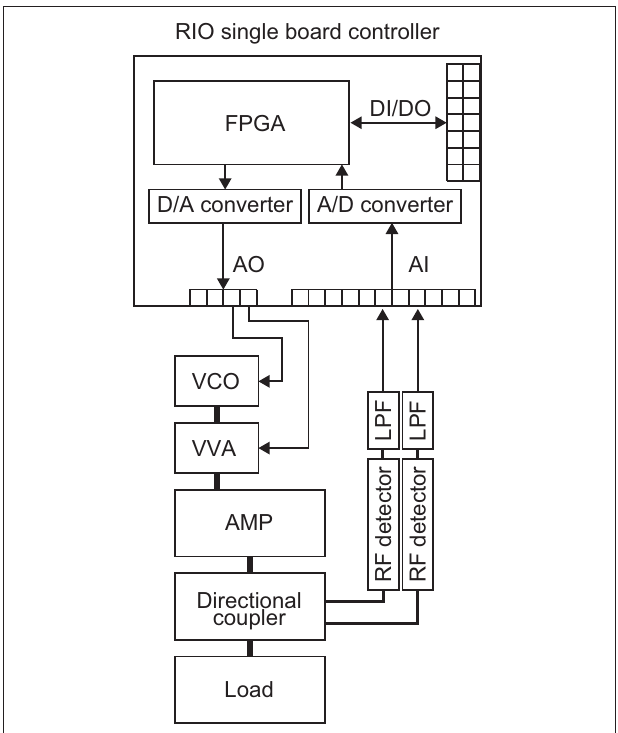
FIGURE 3 | Schematic diagram of the rf system containing a board controller including the FPGA and the AD/DA